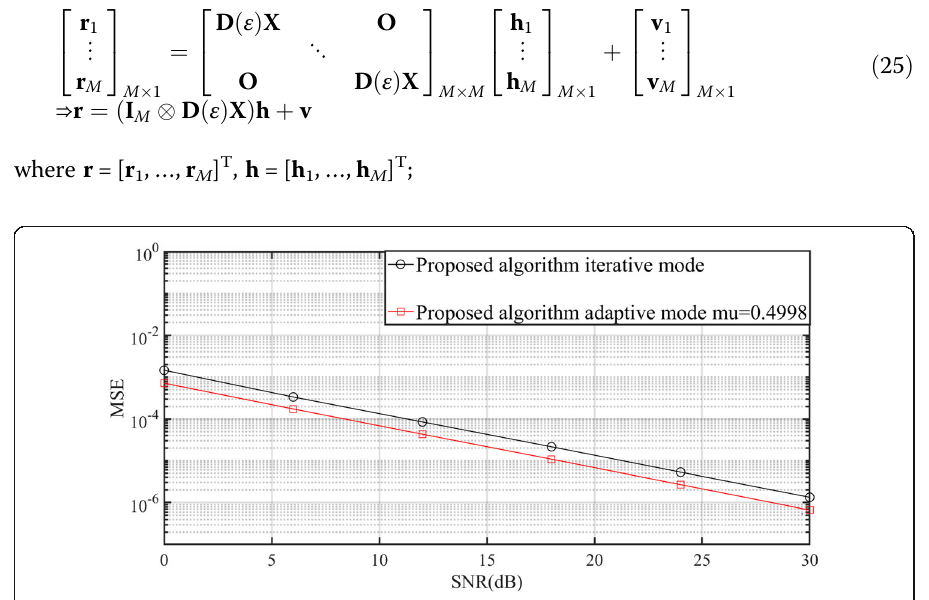
Fig. 10 The MSE performance for CFO estimation in the adaptive mode at v = 60